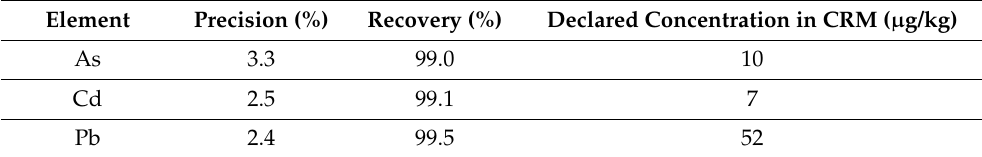
Table 1. Results obtained in the quality control process. Element Precision (%) Recovery (%) Declared Concentration in CRM ( µ g/kg) As 3.3 99.0 10 Cd 2.5 99.1 7 Pb 2.4 99.5